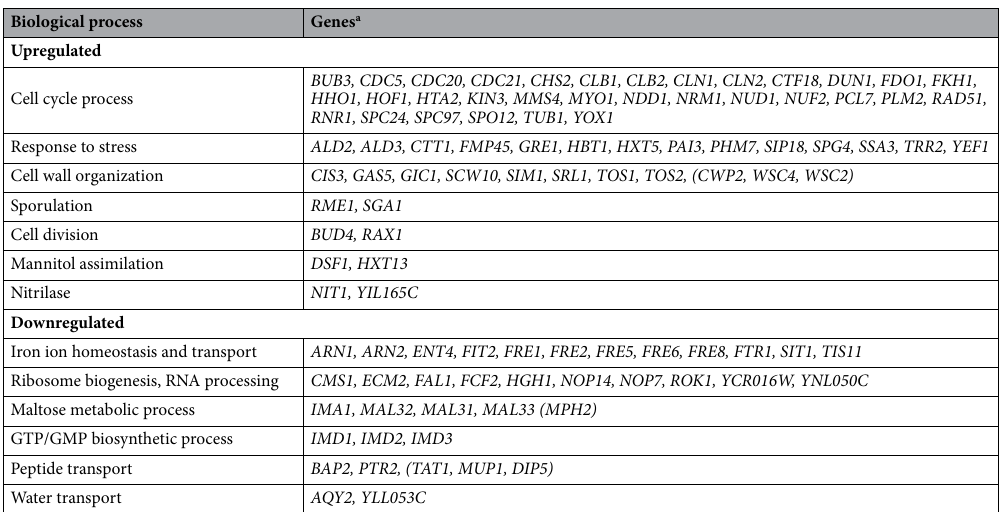
Table 5. STRING analysis of induced and represses genes after evolution of S. cerevisiae F12. a Upregulated and downregulated genes with similar functions and highlighted by GO analysis are listed in